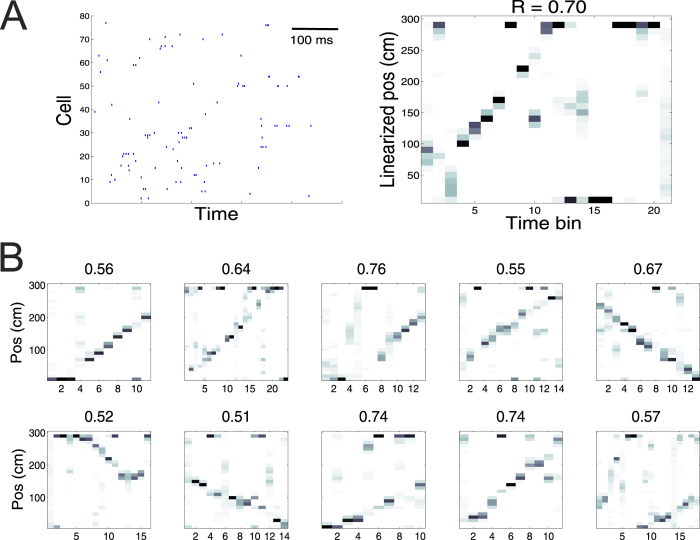
QW-associated ensemble spike data analysis.(A) Example of spike rasters and the associated decoded spatial trajectories in quiet wakefulness. The number at the top of each panel indicates the absolute weighted correlation |R|. (B) Examples of detected significant replays. X-axis represents time bin (bin size Δ = 20 ms).